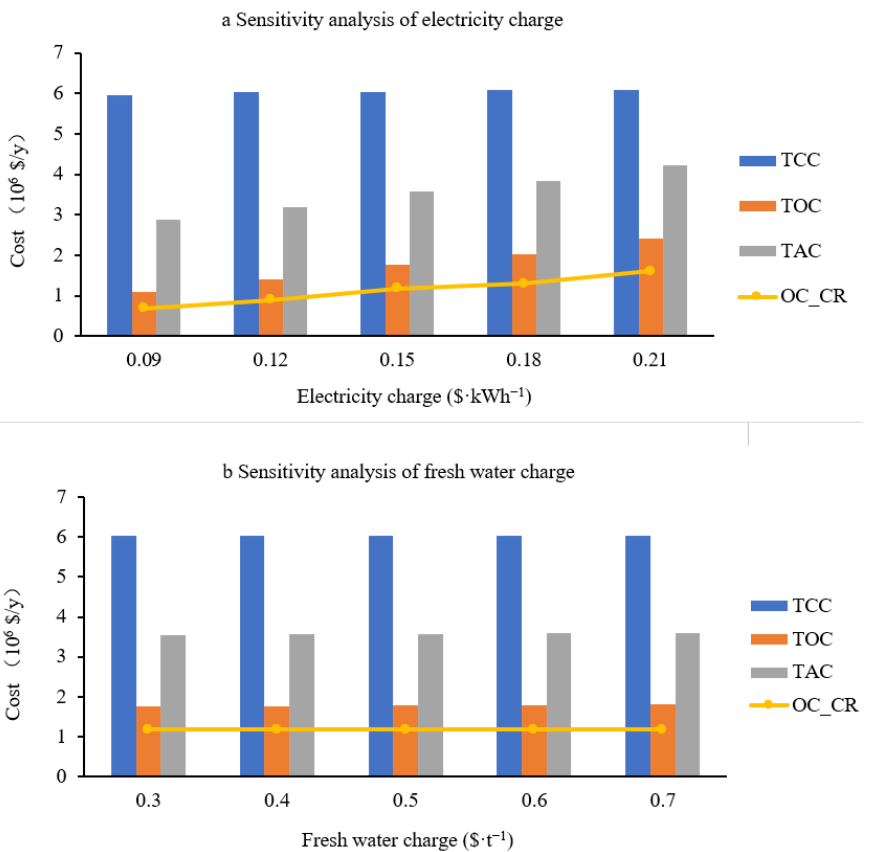
Figure 9. Sensitivity analysis of the cascade cooing system. ( a ) sensitivity analysis of electricity charge; ( b ) sensitivity analysis of fresh water charge